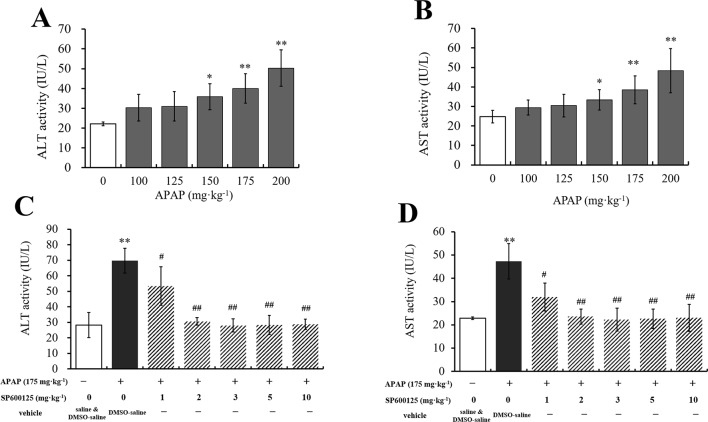
Dosage selection of APAP and SP600125. (A, B) Changes of ALT and AST activities with different dosages of APAP in serum of mice. (C, D) Changes of ALT and AST activities with 175 mg·kg−1 APAP and different dosages of SP600125 in serum of mice. Values represented as means ± SD, n = 6. *Represents statistical differences caused by APAP. #Represents statistical differences caused by SP600125 under the same dose of APAP. 0.05 > P > 0.01 (*, #). P < 0.01 (**, ##).